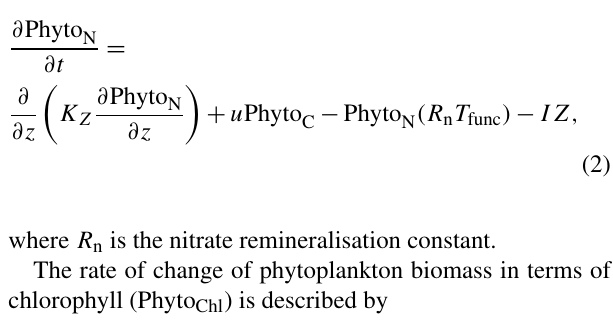
Phytoplankton biomass is also modelled in terms of inter- nal nitrogen, Phyto N . S2P3 v8.0 calculates Phyto N